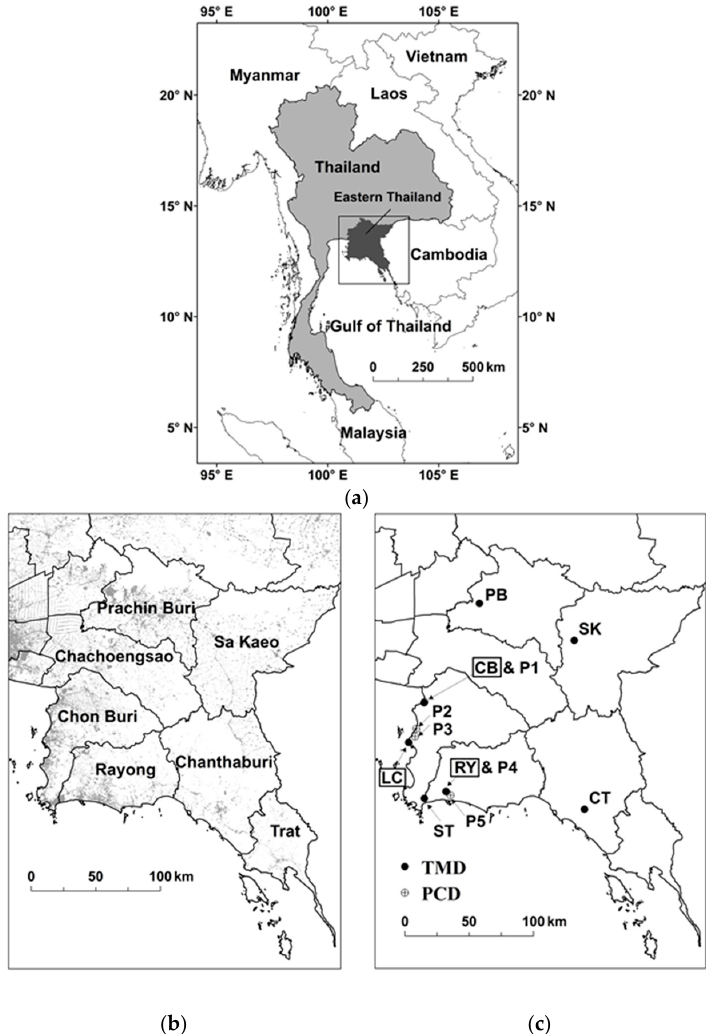
Figure 1. ( a ) Thailand; ( b ) eastern region and its provinces, and ( c ) monitoring stations. In ( b ), built-up areas are shaded grey, representing urban, residential, industrial, and commercial areas combined based on Land Development Department (LDD) (2007) [34]. In ( c ), for some Thai Meteorological Department (TMD) and Pollution Control Department (PCD) stations being very close to each other, only one filled circle is given. CB (Chon Buri), LC (Laem Chabang), and RY (Rayong) (in boxes) denote the most important TMD stations in the analysis, which are paired with nearby PCD stations for air quality data (here, P1 (General Education Office), P2 and P3 (Sri Racha Juvenile Center and Kasetsart University Sri Racha), and P4 and P5 (Rayong Field Crops Research Center and Map Ta Phut Health Center),